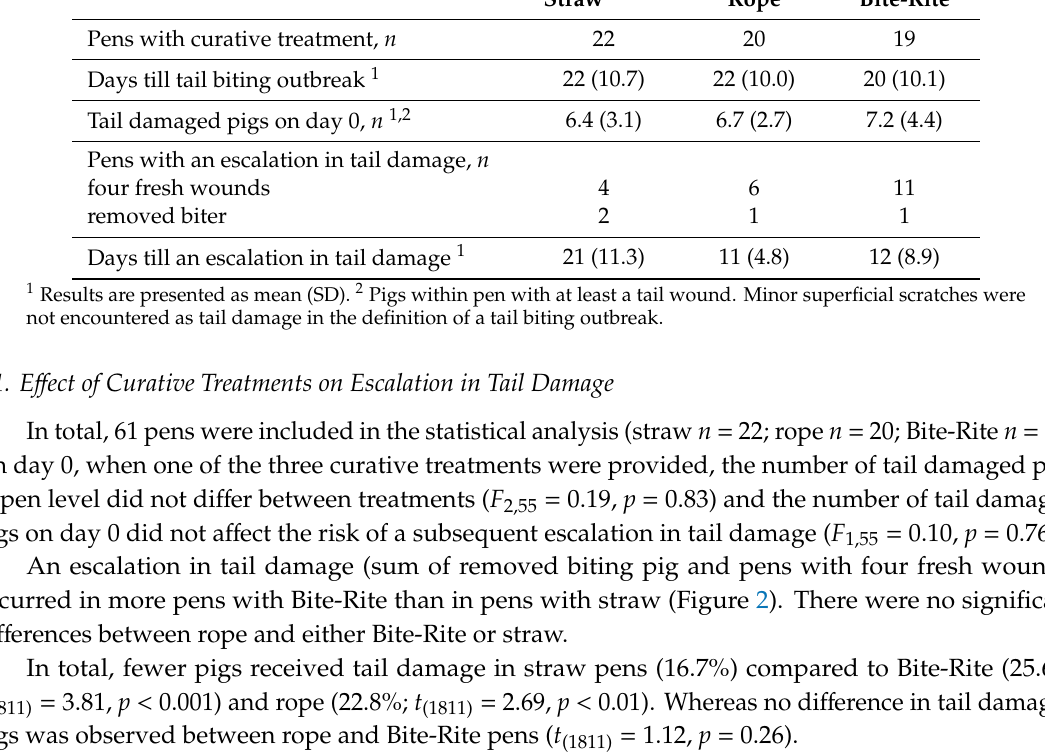
Figure 1. Incidence of first tail biting outbreak at pen level during the study period ( n = 61). Table 4. Number of pens, days until outbreak, tail damaged pigs on day 0, number of pens with an escalation in tail damage, and days until escalation presented within treatment. Treatment Straw